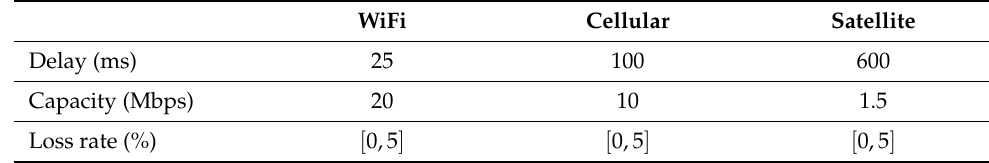
Table 2. Network parameters for different technologies.